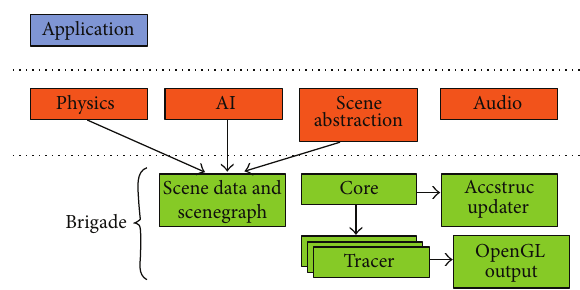
Figure 6: Functional overview of the Brigade renderer, combined with a generic game